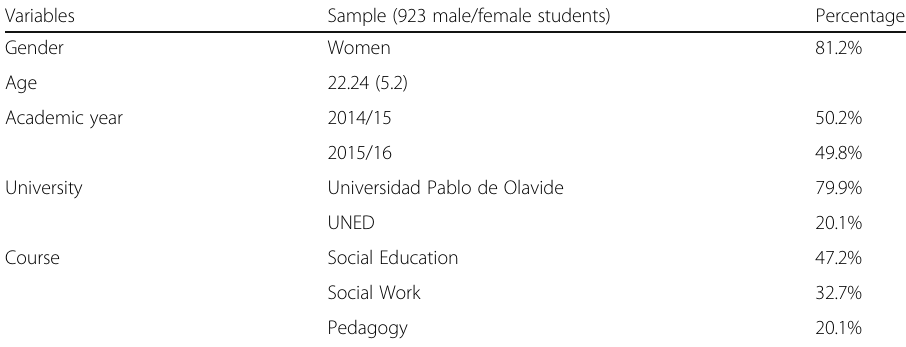
Table 1 Descriptive statistics of the sample